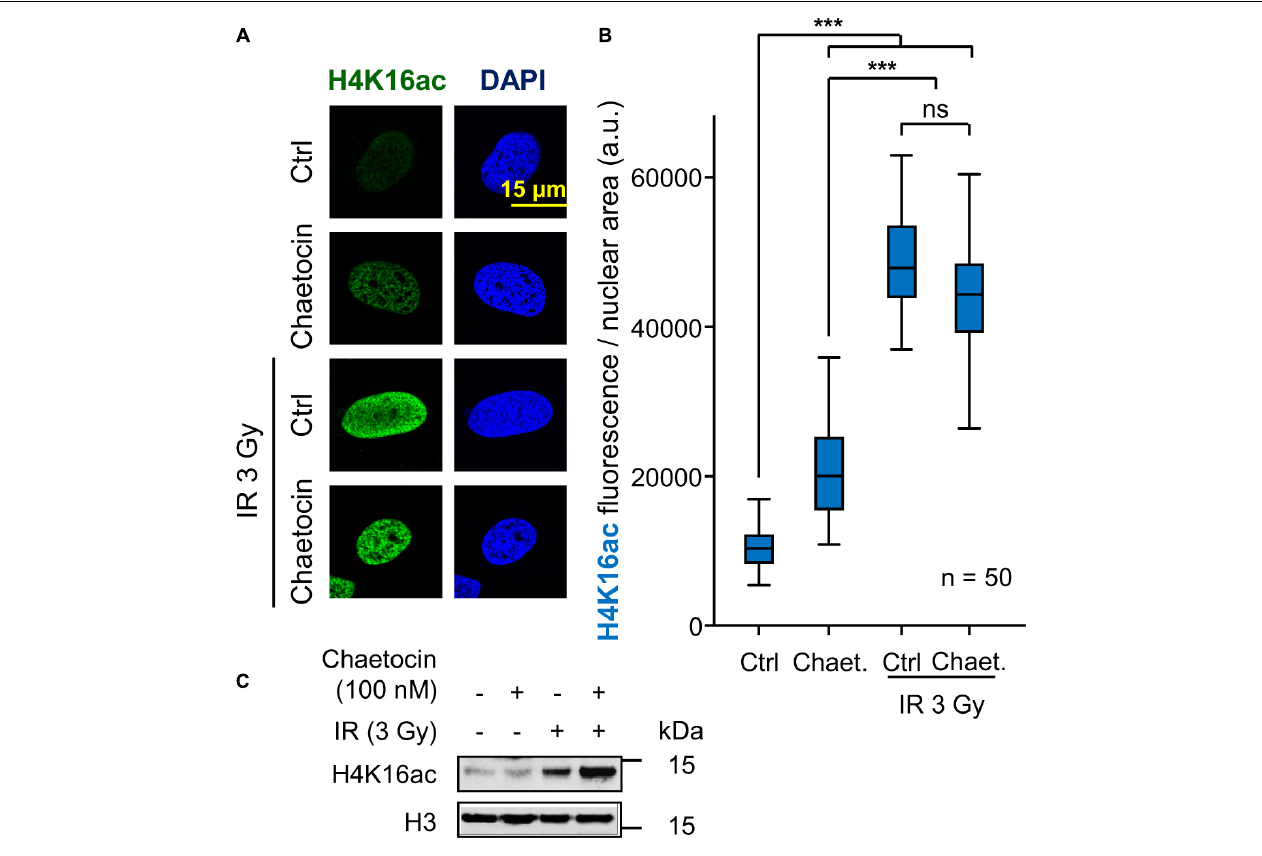
FIGURE 5 | Effect of chaetocin on the acetylation of histone H4 in lysine 16 (H4K16ac) in U2OS cells treated with IR. (A) Detection of H4K16ac by immunofluorescence. (B) Quantification of the increase in H4K16ac induced by IR. ns, not significant, *** p < 0.001. (C) Immunoblot to show the increase of H4K16ac levels by IR. These images only show the detail in one cell selected for presentation. The field images are shown in Supplementary Figure 8 . Ctrl, control without chaetocin. Chaet, chaetocin (100 nM).